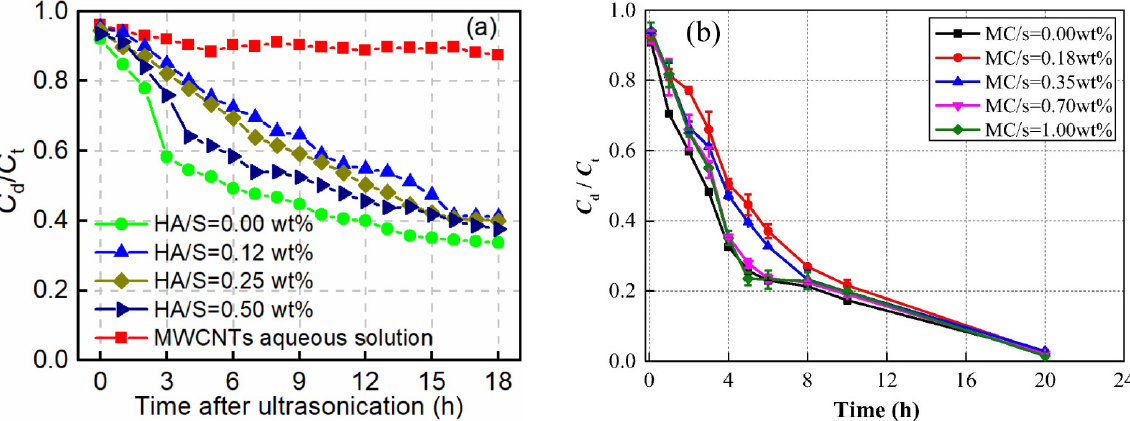
Figure 4: The dispersion degree ( C d / C t ) of CNTs in simulated cement pore solutions containing varying content of (a) humic acid (HA) [100] and (b) methylcellulose (MC) [101] over time